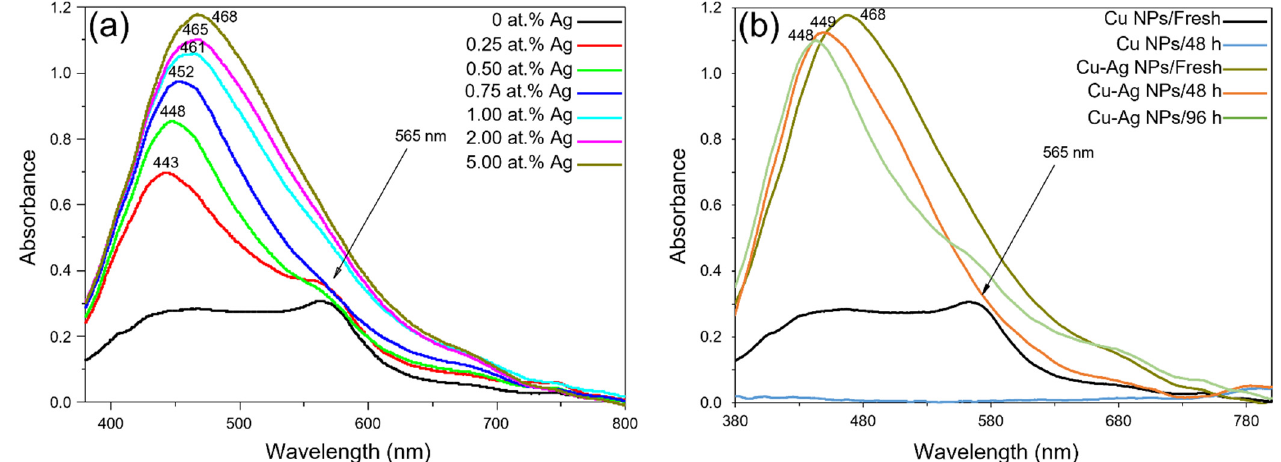
Figure 2. ( a ) Optical spectra of Cu–Ag NP colloids (diluted) at different silver concentrations; ( b ) optical spectra of Cu NP and Cu–Ag NP (~5 at.% Ag) colloids (diluted) at different times after their